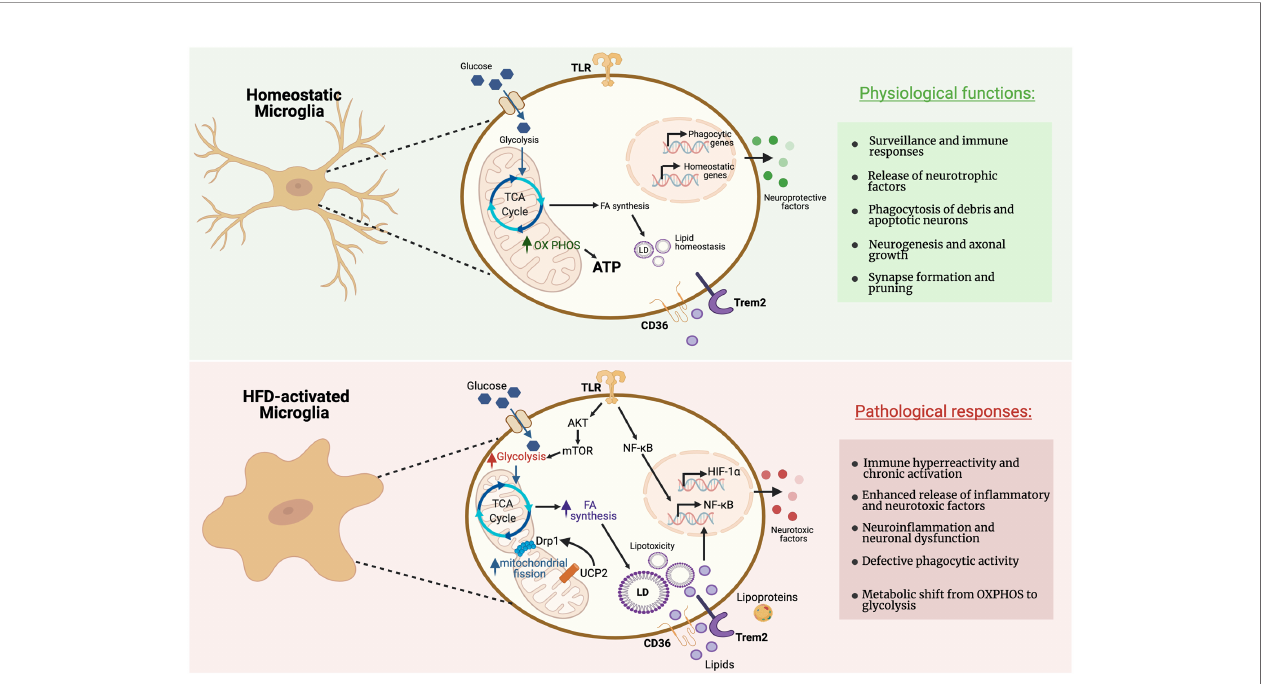
FIGURE 2 | Metabolic pathways regulating microglial activity during homeostasis and pathological responses. Microglia can rapidly adapt their energy metabolism to nutrient availability and transcriptomic analyses revealed that microglia express genes necessary for both glycolysis and oxidative metabolism. Microglia in their homeostatic status show reliance on oxidative metabolism to maintain their neuroprotective properties. However, microglia in proin fl ammatory states preferentially use glycolysis for energy production. This metabolic switch towards glycolysis allows microglia to produce ATP rapidly, despite being comparatively less ef fi cient, for the secretion of in fl ammatory cytokines. High-fat diet (HFD) triggers a microglial in fl ammatory response leading to neuronal dysfunction in the MBH. Figure created with